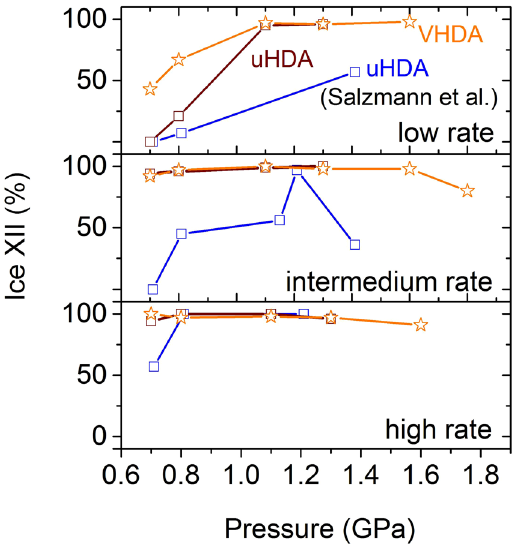
Figure 5. Relative yield of ice XII in crystalline phase mixtures at given pressures and heating rates. Values obtained after crystallisation from VHDA are coloured in orange, from uHDA in brown and values from literature in